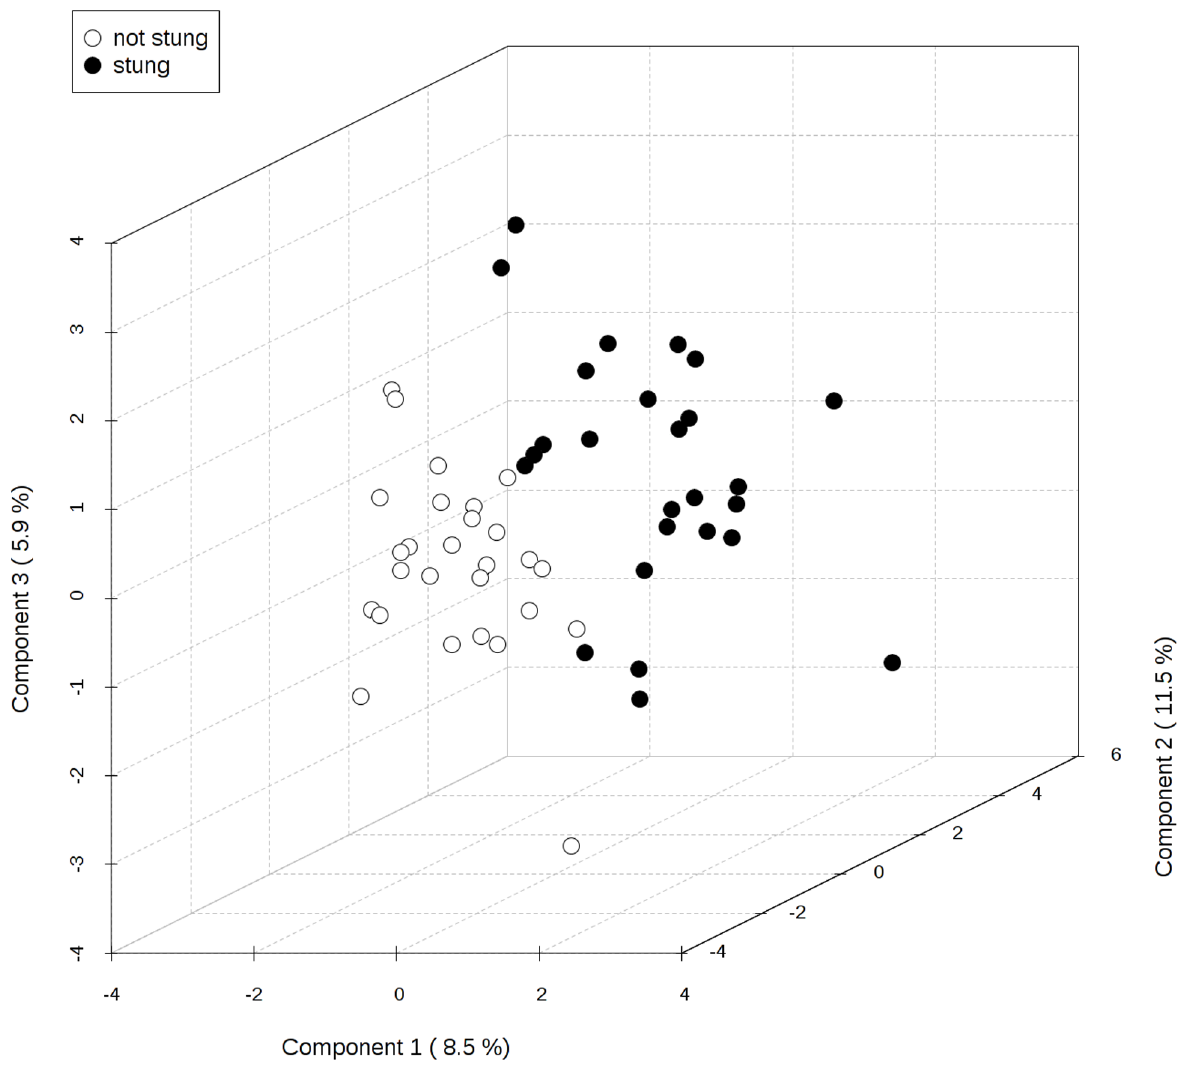
Figure 2. Three-dimensional (3D) partial least squares discriminant analysis separation using amino acids concentration-based metabolomics measurements in the serum of the beekeepers directly after a bee sting vs. the serum of the beekeepers after at least six weeks since the last sting (27 cases). The explained variances are shown in brackets.